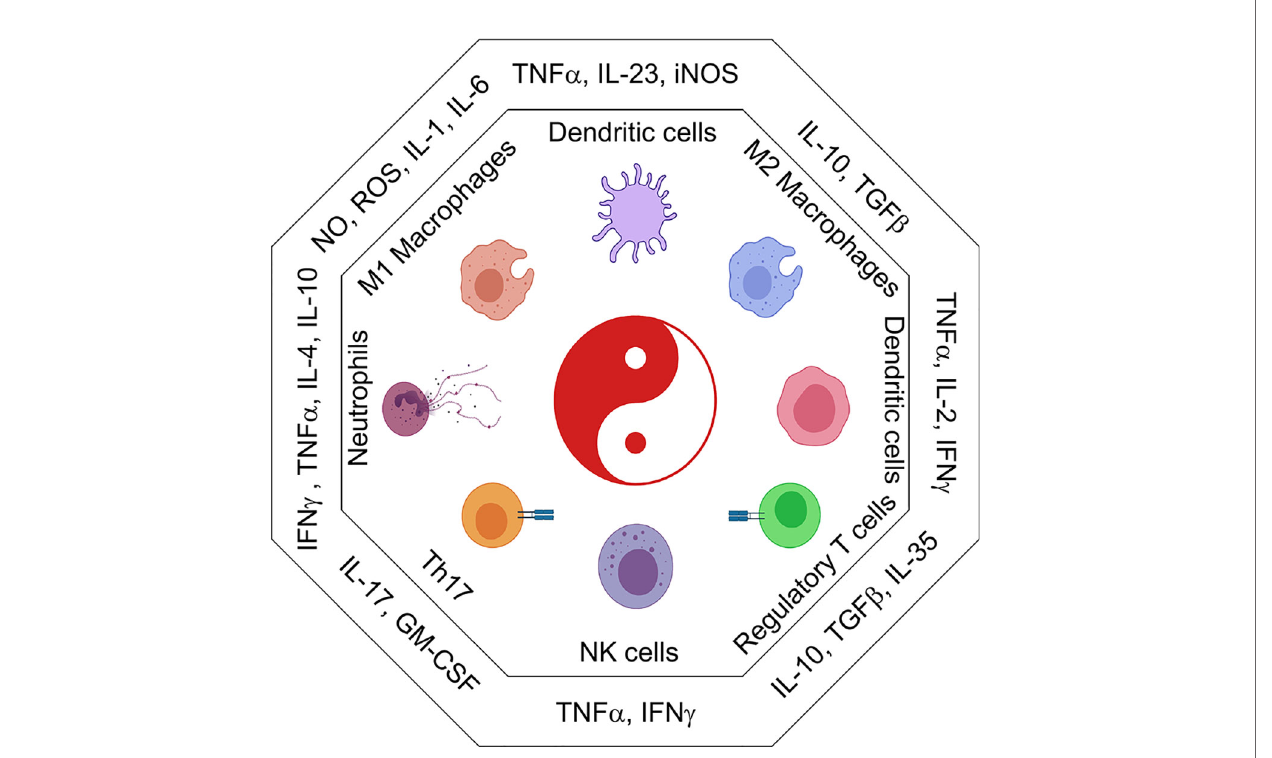
FIGURE 2 | The immune cell universe in myeloid malignancies. Schematic representation of adaptive and innate immune subsets and their associated cytokines and secreted factors. Depending on the cytokine context immune cells take on distinct effector and regulatory pro fi les some are good, some are bad. These functions are characterized by the secretion of pro-in fl ammatory (IL1 b , IL6, TNF a , CSFs) or suppressive (IL10, TGF b , IL35) cytokines. Uncontrolled regulation of cytokines can result in the development of in fl ammatory leukemic